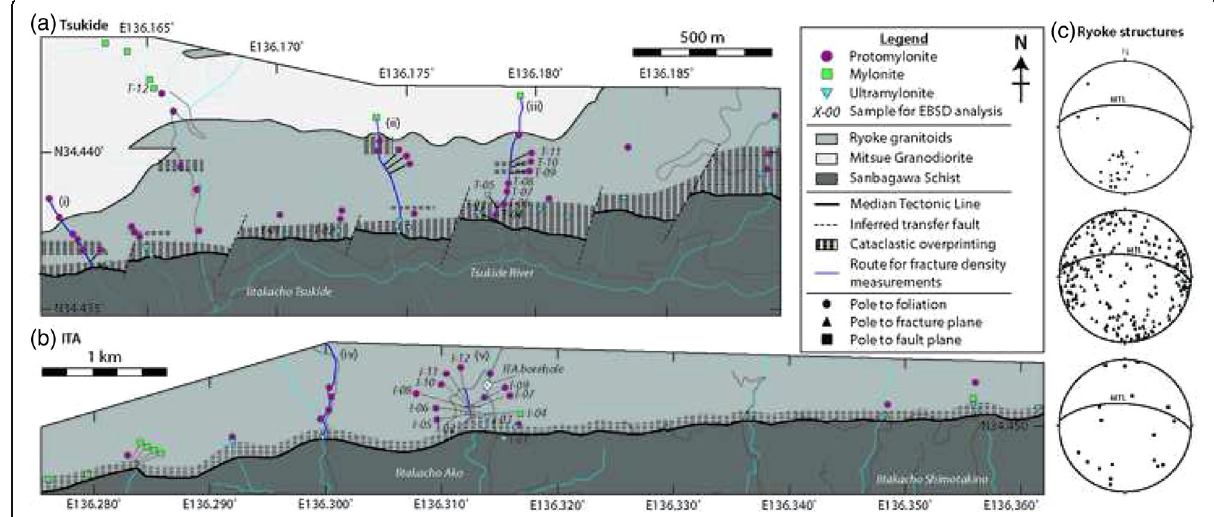
Fig. 2 Geological maps of the Tsukide ( a ) and Ako – Miyamae ( b ) areas showing the location of samples discussed in the text, and the orientation of foliations, fractures, and fault planes measured in the hanging wall of the MTL ( c ). The location of the MTL in the central section of ( b ) is after Shigematsu et al. (2012). The location of the boundary between the Hatai Tonalite and the Mitsue granodiorite is after Shigematsu (unpublished